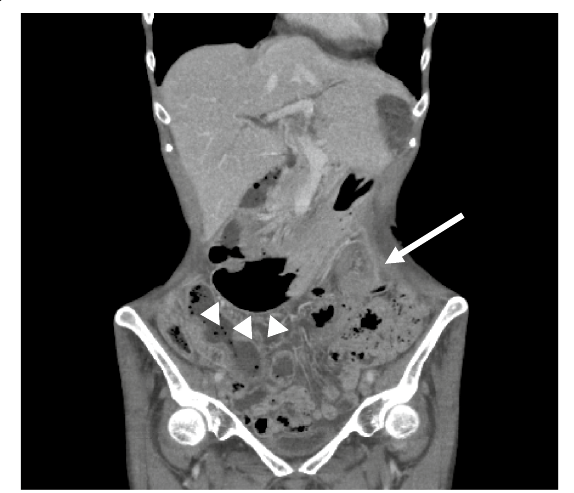
Fig. 5 CT showed the position of the stomach after laparoscopic gastropexy was to the right of the lifted sigmoid colon. A white arrow and arrowheads point to the sigmoid colostomy and the stomach, respectively